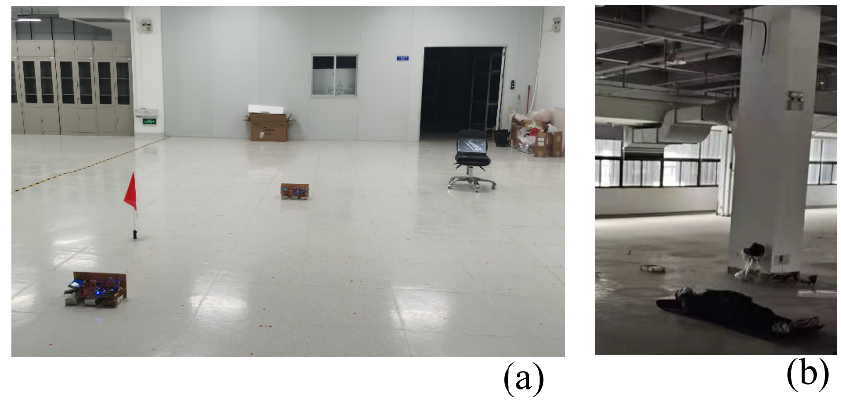
Figure 18. The experimental setup for a multistorey building. ( a ) The deployment of two Golay-coded radars. ( b )The tested human object.